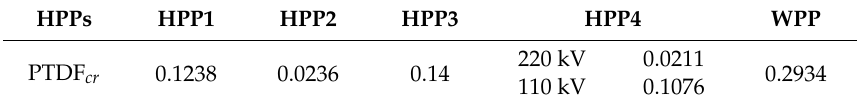
Table 4. Calculated power transfer distribution factor (PTDF) values for the critical line.